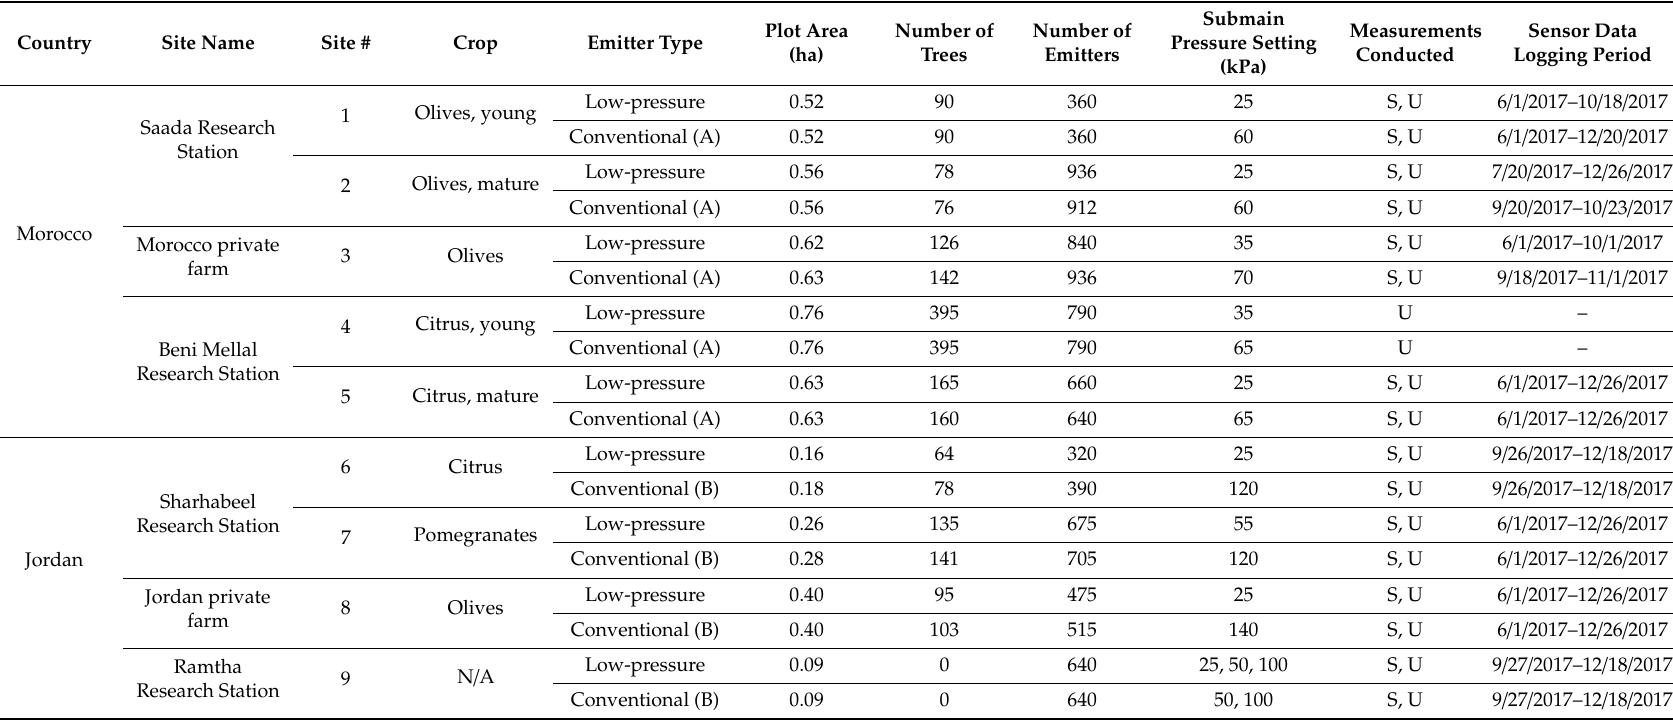
Table 2. Details of experimental sites, including the plot area, number of trees, number of emitters, and the measurements conducted at each site (S = sensor measurements, U = uniformity). The submain pressure setting was determined using the procedure described in Section